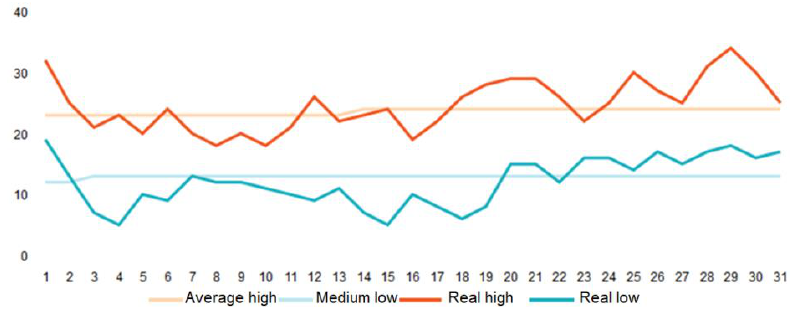
Figure 3. Temperature conditions in Lodz in July 2019 .